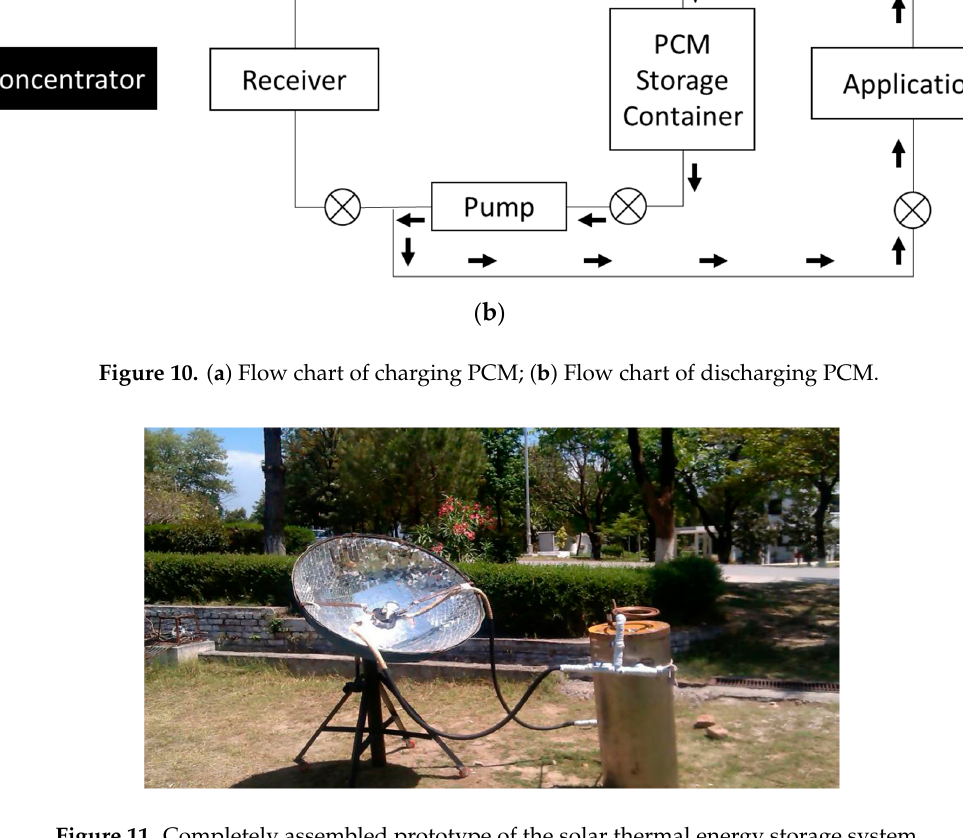
Figure 11. Completely assembled prototype of the solar thermal energy storage system.